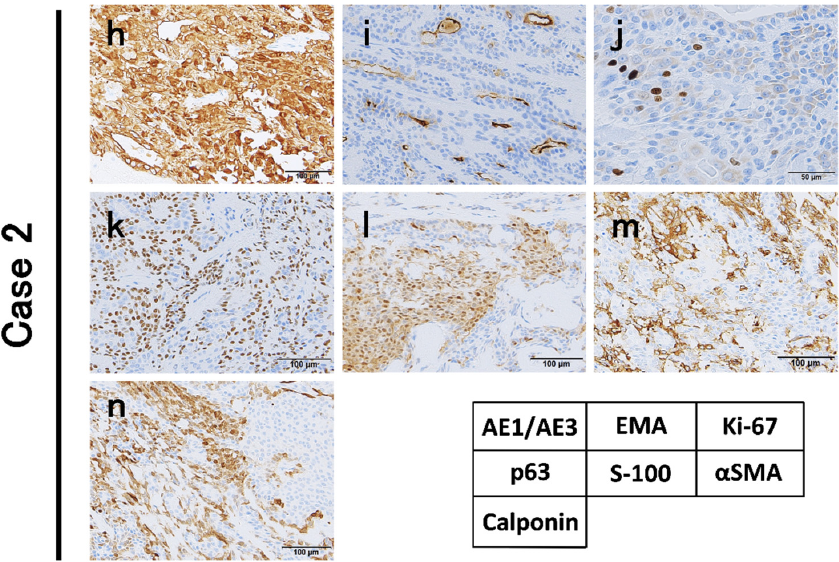
Figure 3. Immunohistochemical pattern of the present cases with epithelial-myoepithelial carcinoma. ( a , h ) The tumor was diffusely positive for AE1/AE3. ( b , i ) Glandular duct-forming cells were positive for epithelial membrane antigen (EMA). ( c ) Ki-67 showed active fission images and a high Ki-67 labeling index (10.6%). Neoplastic myoepithelial cells were positive for ( d , k ) p63, ( e , l ) S-100, ( f , m ) α -smooth muscle actin ( α -SMA), and ( g , n ) Calponin. In case 2, ( m ) Tumor nests were diffusely positive for S-100 protein. ( j ) Ki-67 labeling index was low (3.8%).